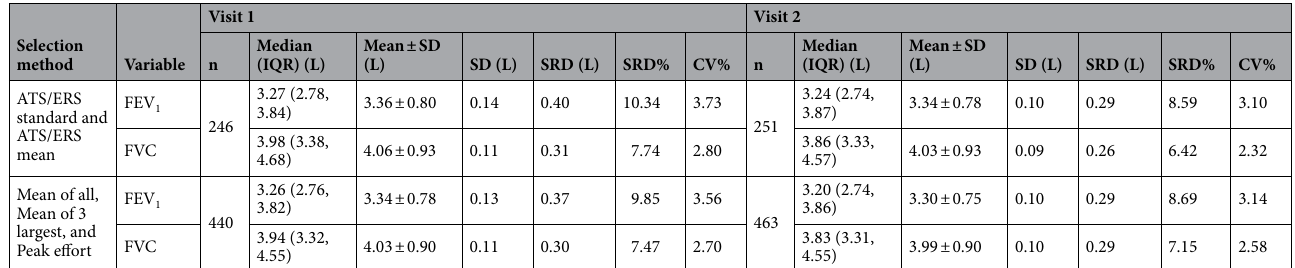
Table 4. Intra-session descriptive statistics and variability by selection method for forced vital capacity (FVC) and forced expiratory volume in one second (FEV 1 ) (n = 78 subjects). ATS/ERS refers to the current selection method recommended by the American Thoracic and European Respiratory Societies. Data for descriptive statistics are presented as mean ± 1 standard deviation (SD) or median (interquartile range,